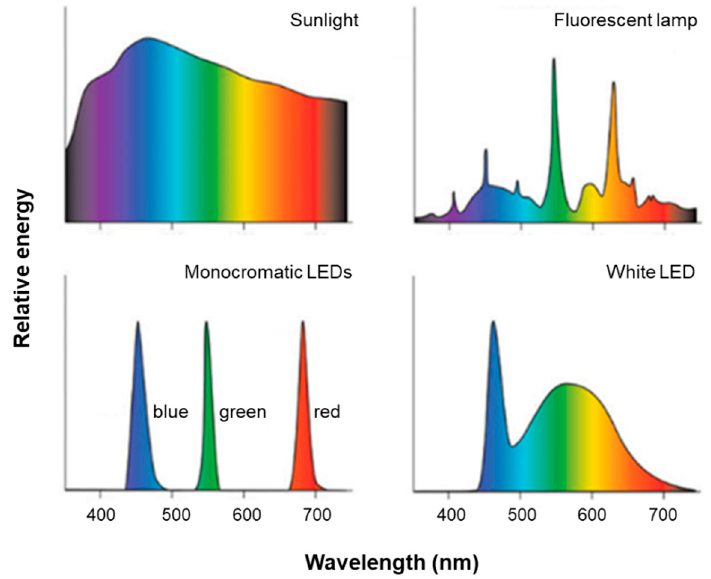
Figure 4. Spectral output of sunlight vs. different artificial lighting systems. Modified from [59] .